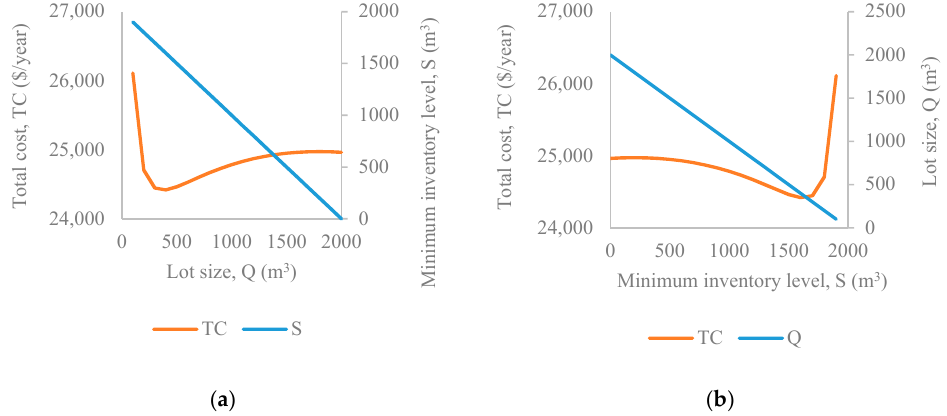
Figure 3. Total cost and ( a ) optimal minimum inventory level as a function of the lot size; ( b ) optimal lot size as a function of the minimum inventory level.